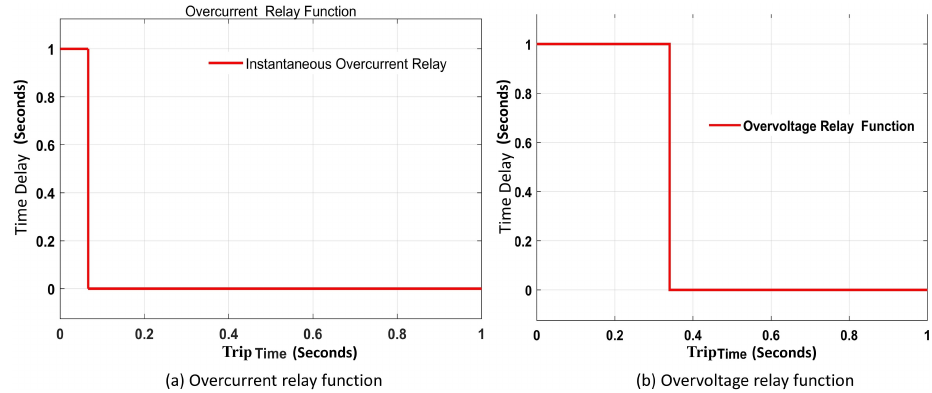
Figure 6. The overcurrent and voltage relay function at relay 1 before setting. Figure 7 represented the initial condition when the trip time was 0.35 s without setting